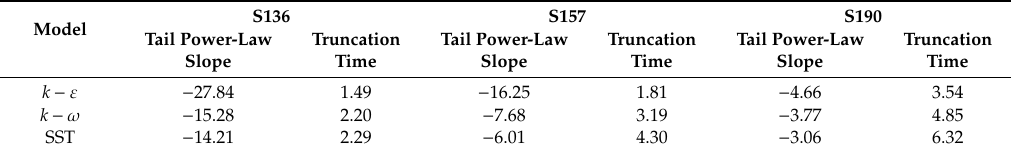
behaviors of solute particle